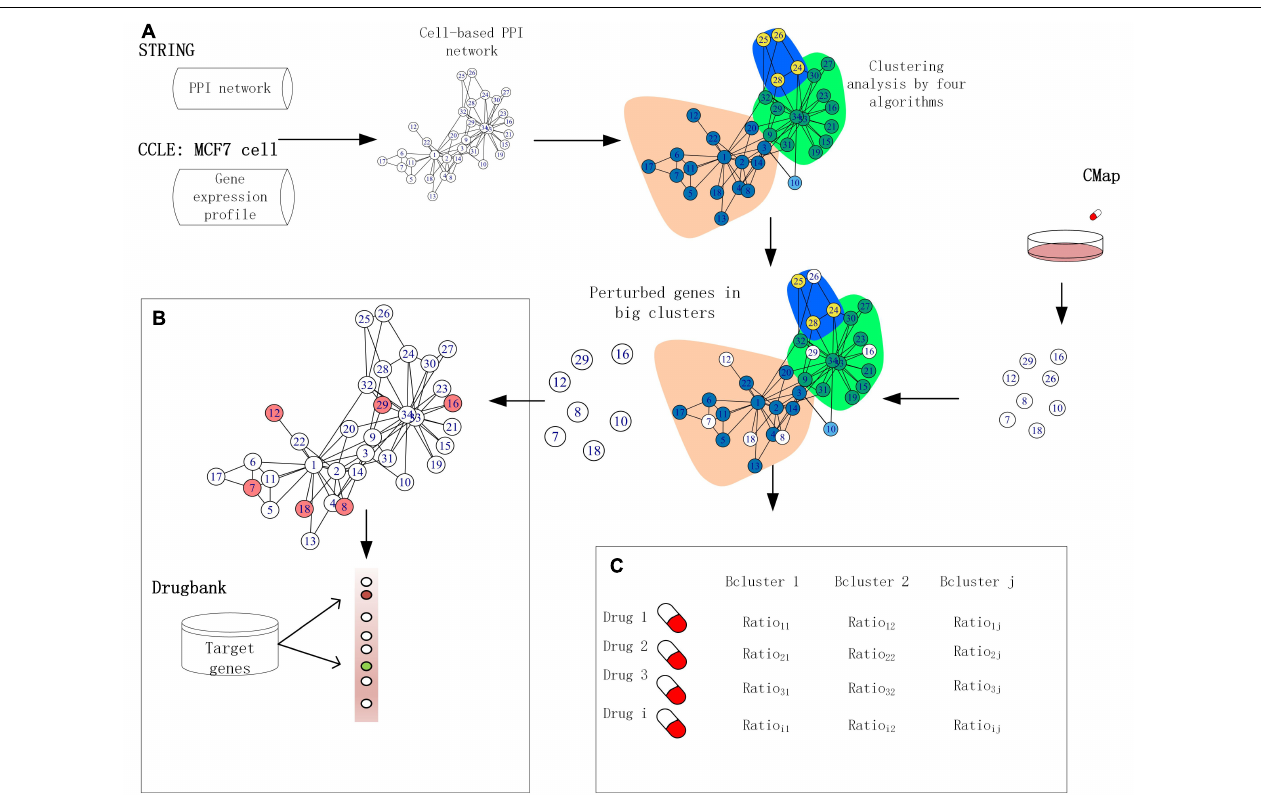
FIGURE 1 | Framework for application of functional clusters. (A) The interactions in the human protein–protein interaction (PPI) network were removed if the corresponding proteins were not expressed in the MCF-7 cell lines. The clusters were built by four module detection algorithms. (B) The target genes were ranked based on the score produced by combining the perturbed genes of big size clusters with network information. (C) Cancer drugs by similarity analysis based on the fraction of perturbed genes in